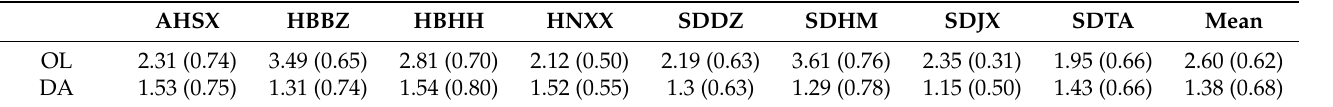
Table 4. Root-mean-square errors ( RMSEs ) and correlation coefficients ( R ) for the RSMI based on open-loop (OL) and assimilated soil moisture (DA) at the eight sites. R values are shown in